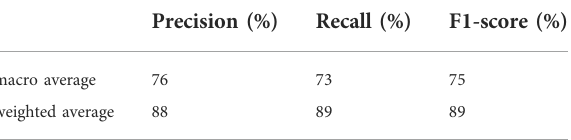
TABLE 8 The performance of the